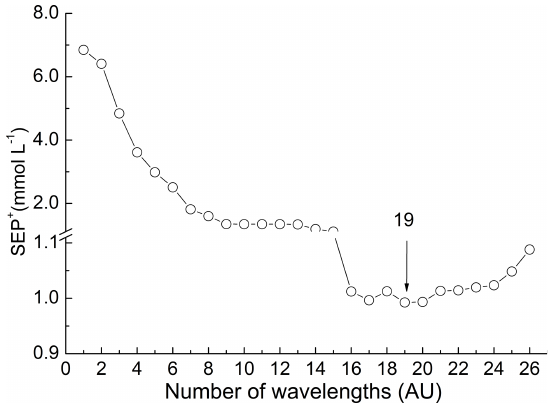
Fig. 5. Change in SEP þ values in the step-by-step wavelength phase-out process based on the optimal EC-PLS model.